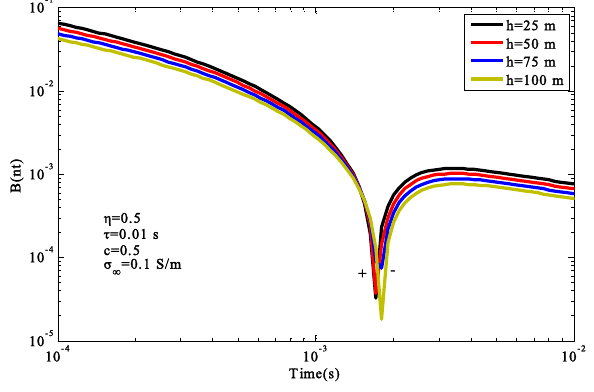
Figure 12. IP e ff ects at di ff erent flight altitudes. Figure 12. IP effects at different flight altitudes. Figure 12. IP effects at different flight altitudes.